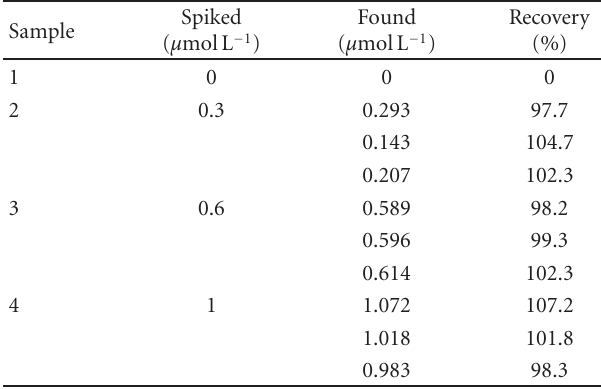
Table 1: Analytical results of apple samples and recovery test.